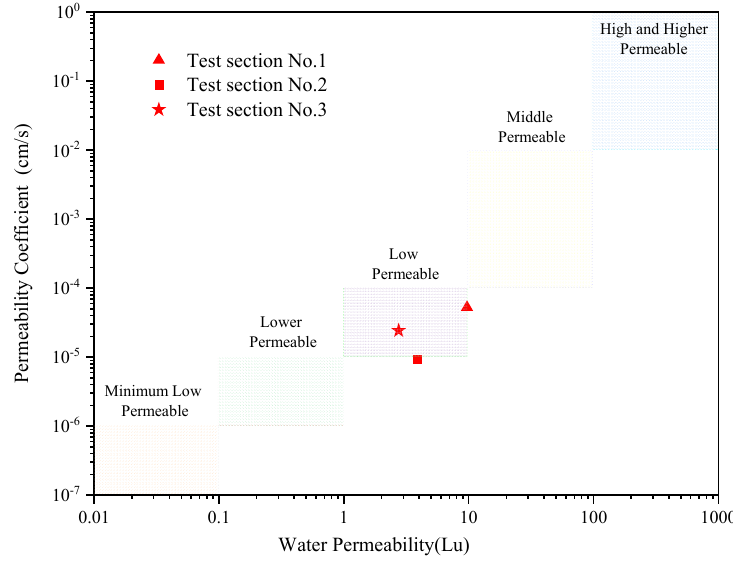
Figure 9. Comparison of water pressure test and slug test results.